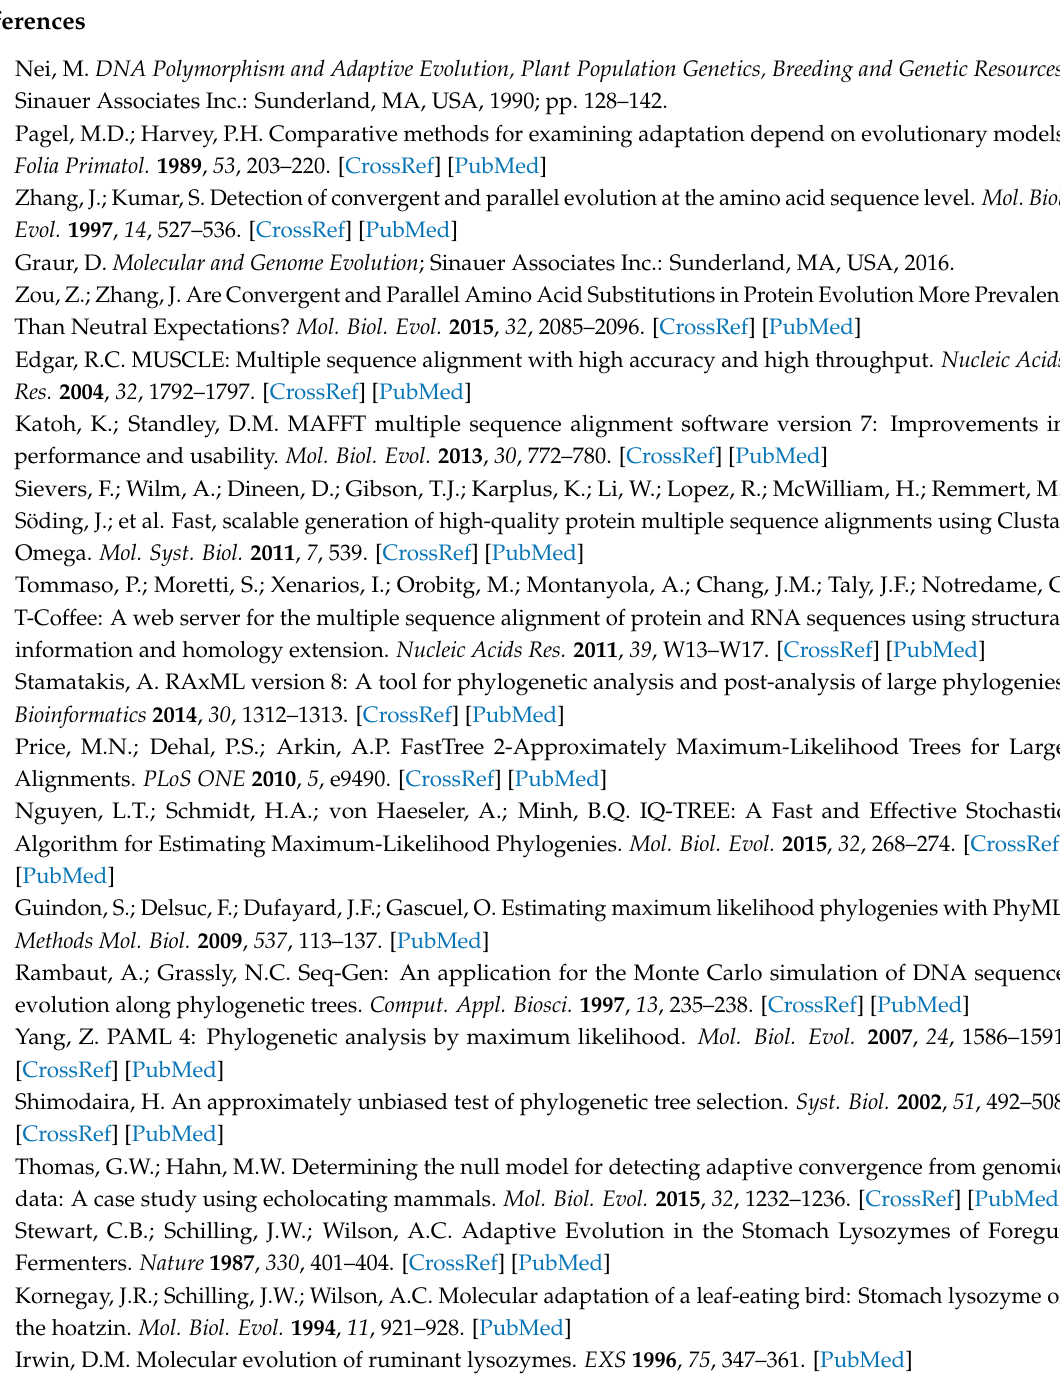
Table S1: Details of supported programs in ProtParCon